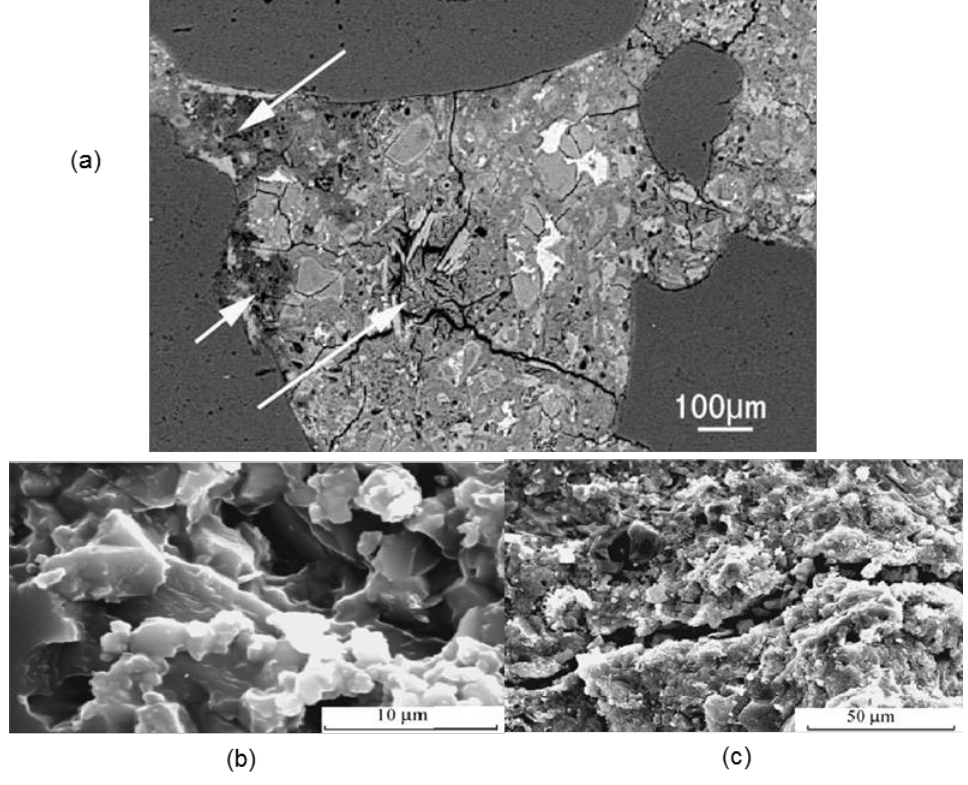
Figure 2. Scanning electron micrographs of sulfate-corroded concrete: ( a ) corroded, 100 μm; ( b ) non-corroded, 10 μm; and ( c ) corroded, 50 μm.